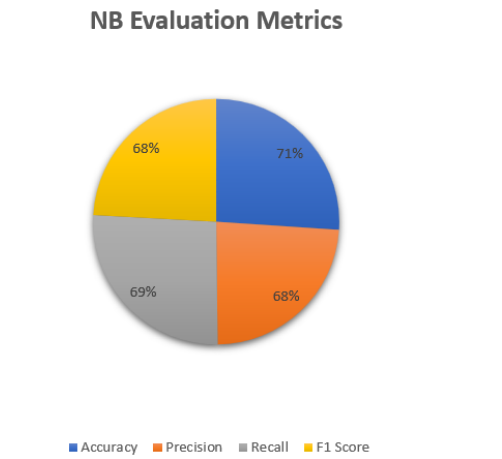
Figure 8. The Naive Bayes Evaluation Metrics.